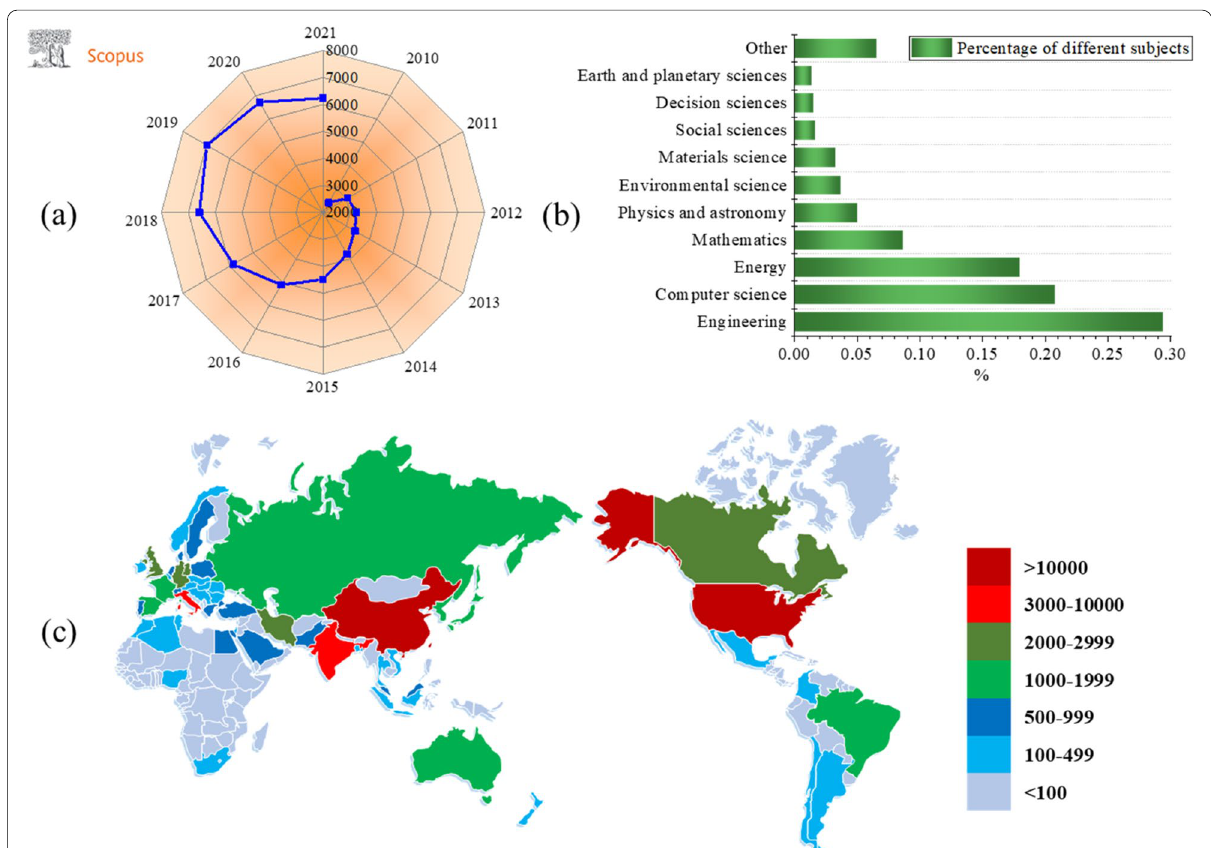
Fig. 3 Research on distributed energy systems in the last decade: a articles published annually, b percentage of different subjects, c number of articles by country